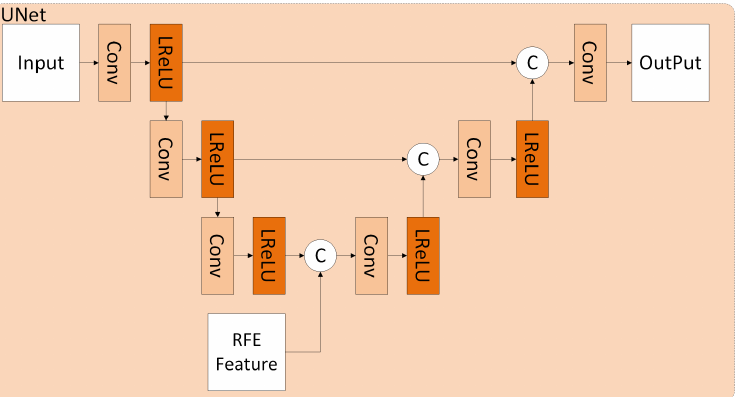
Figure 6. Architecture of the